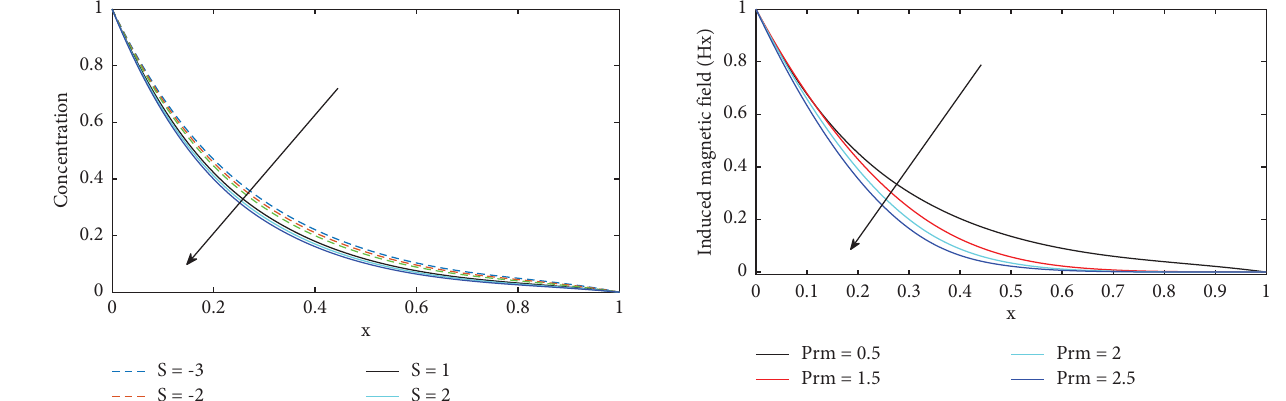
Figure 11: Induced magnetic feld profles for diferent values of Prm.